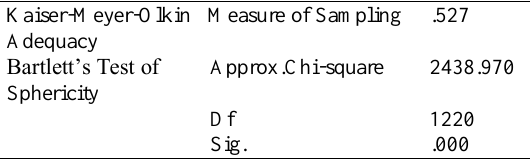
Table 3: Kaiser-Meyer-Olkin Measure of Sampling Adequacy and Bartlett’s Test of Sphericity